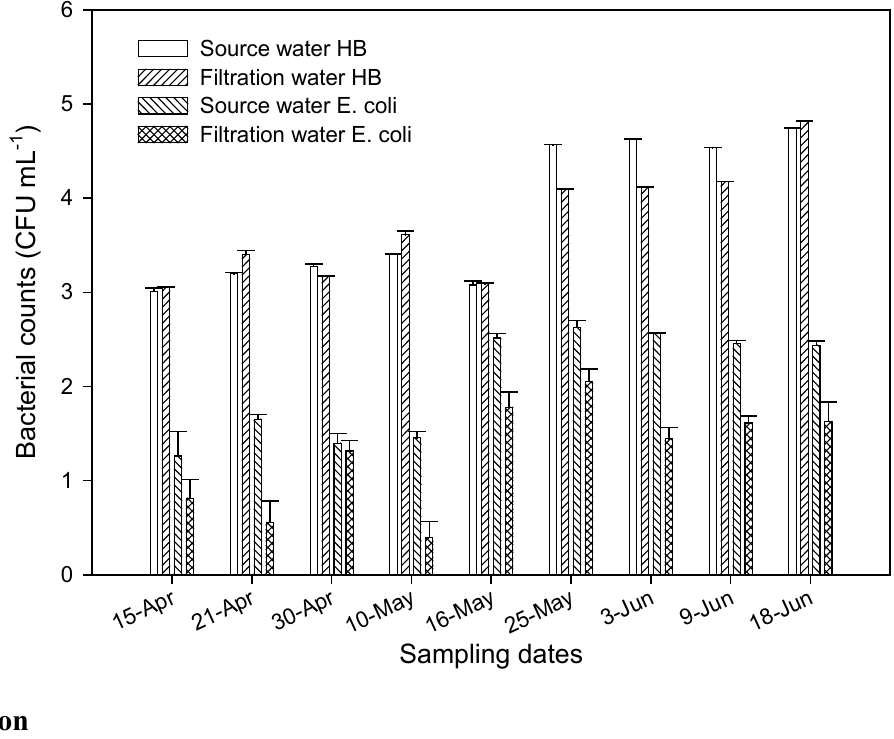
Figure 4. Levels of heterotrophic bacteria (HB) and E. coli as determined by plate count in the source water and after filtration through aquifer sand material. All samples were taken in April through June